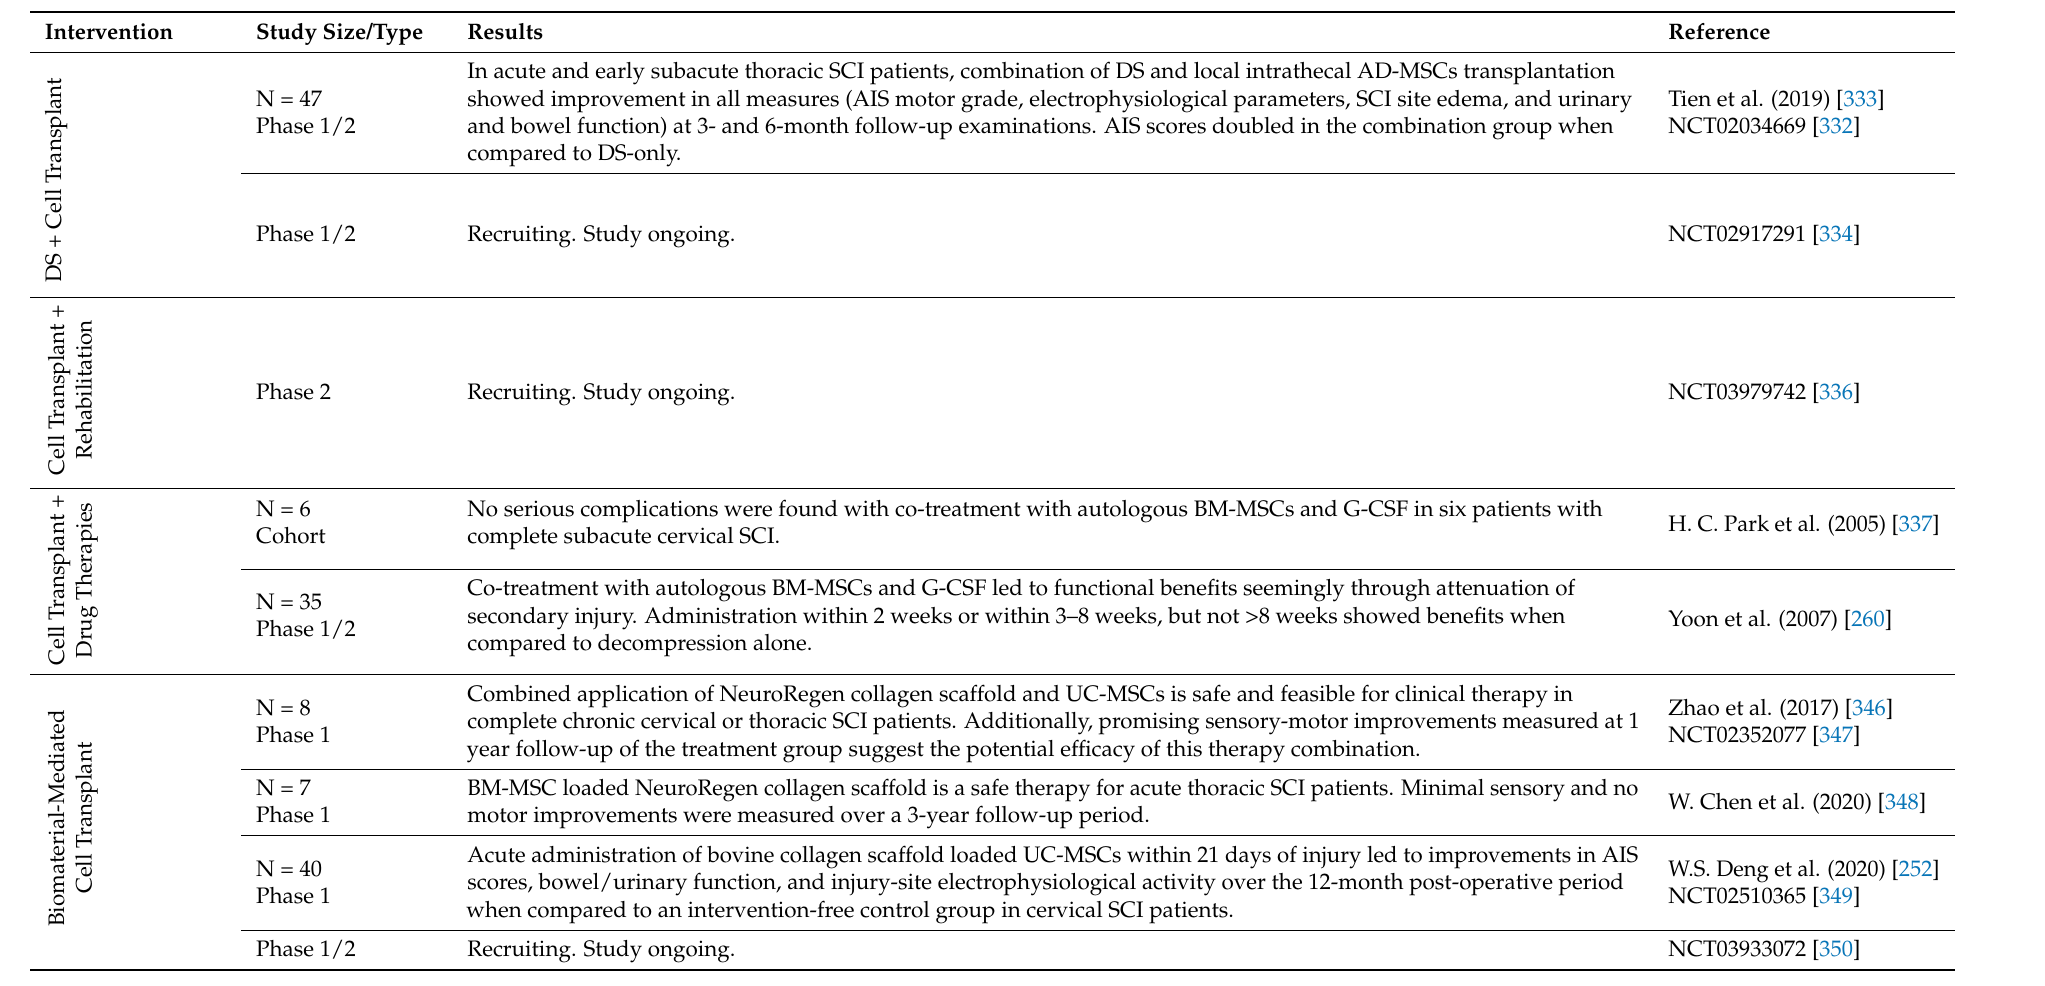
Table 4. Clinical Studies of Combinatorial